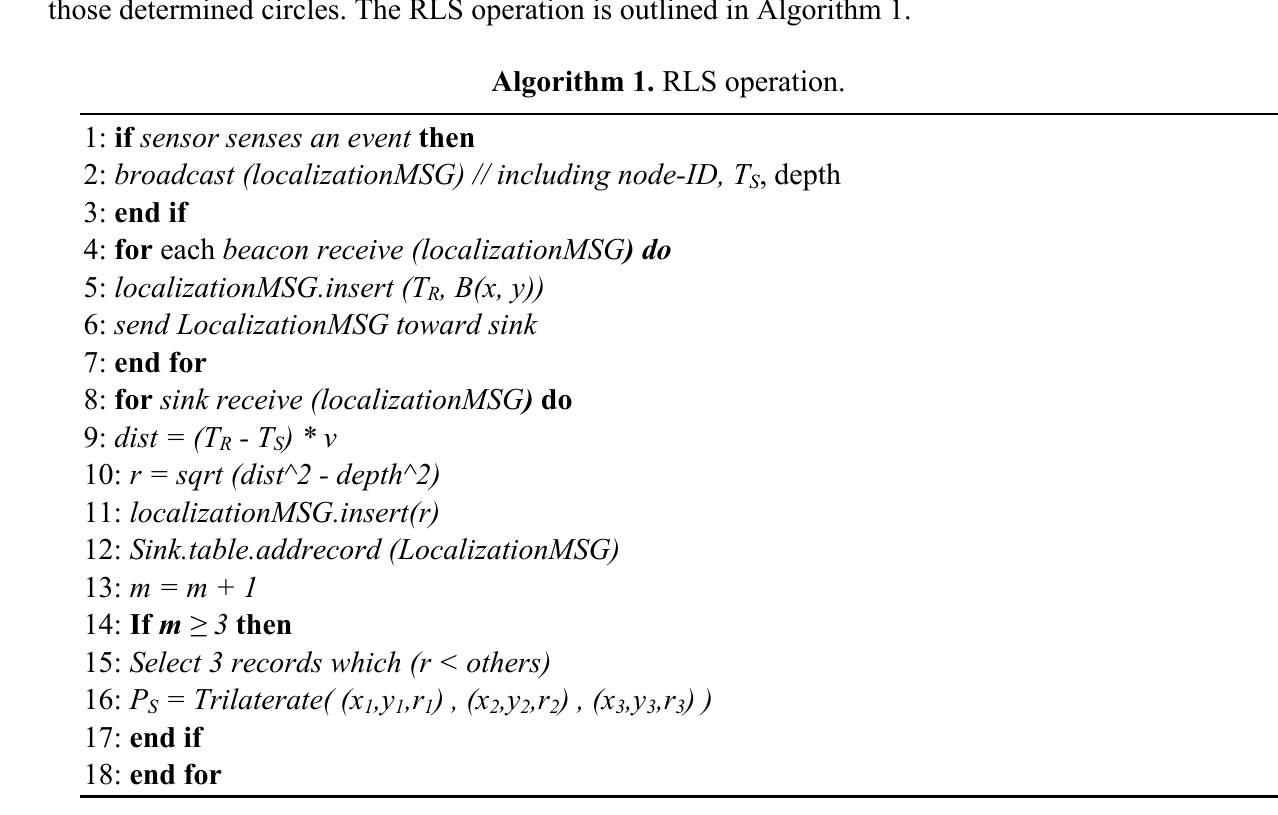
Algorithm 1. RLS